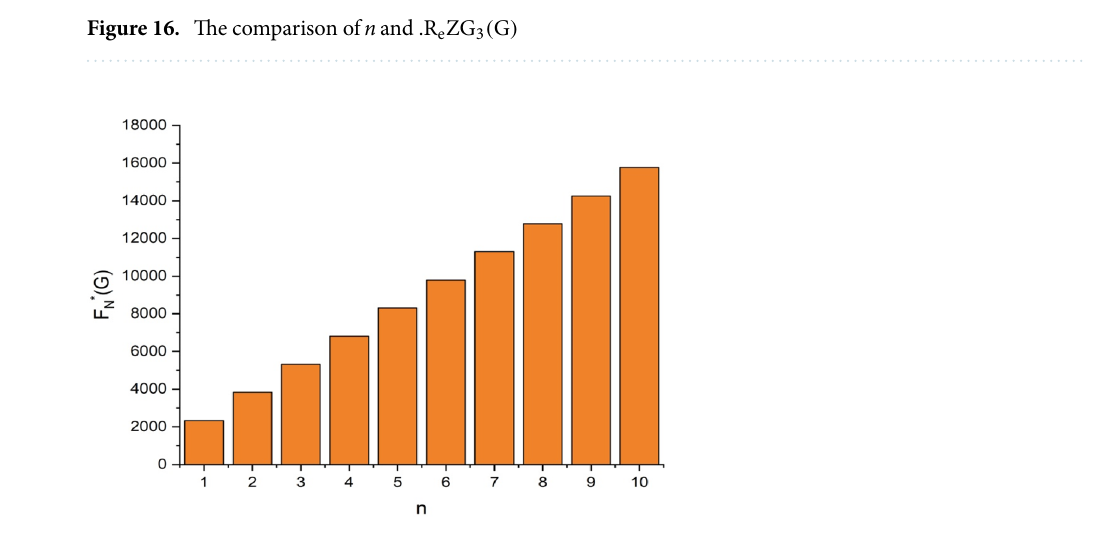
Figure 17. The comparison of n and F ∗ N ( G )